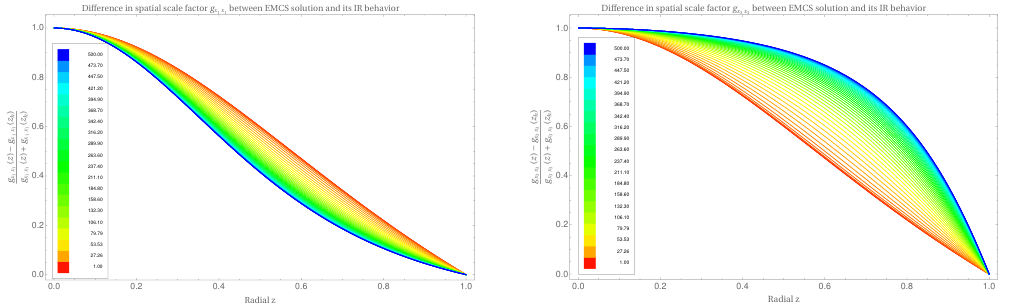
Figure 5 . Deviations of the charged magnetic black brane geometry from its near-horizon behavior. We display the relative difference between the spatial scale factors g x Einstein-Maxwell-Chern-Simons theory and their near horizon behavior. The inset legend displays the coloring for different values of B/T 2 . Note that the near horizon behavior in the transverse direction x 1 is extended towards the boundary by increasing B/T 2 , while the near horizon behavior for the parallel direction x 3 is pushed towards the